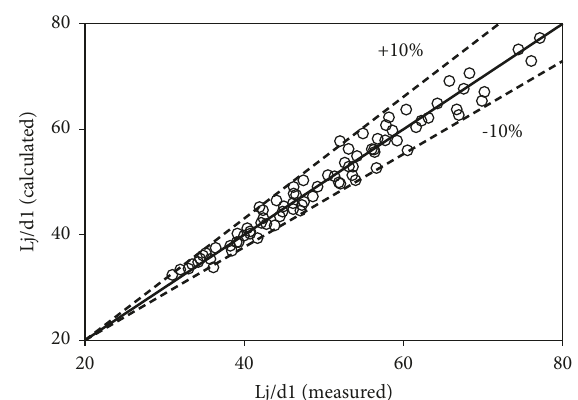
Figure 11: Variations of the Jump length ratio ( L for different negative steps and heights of roughness. of Fr 1